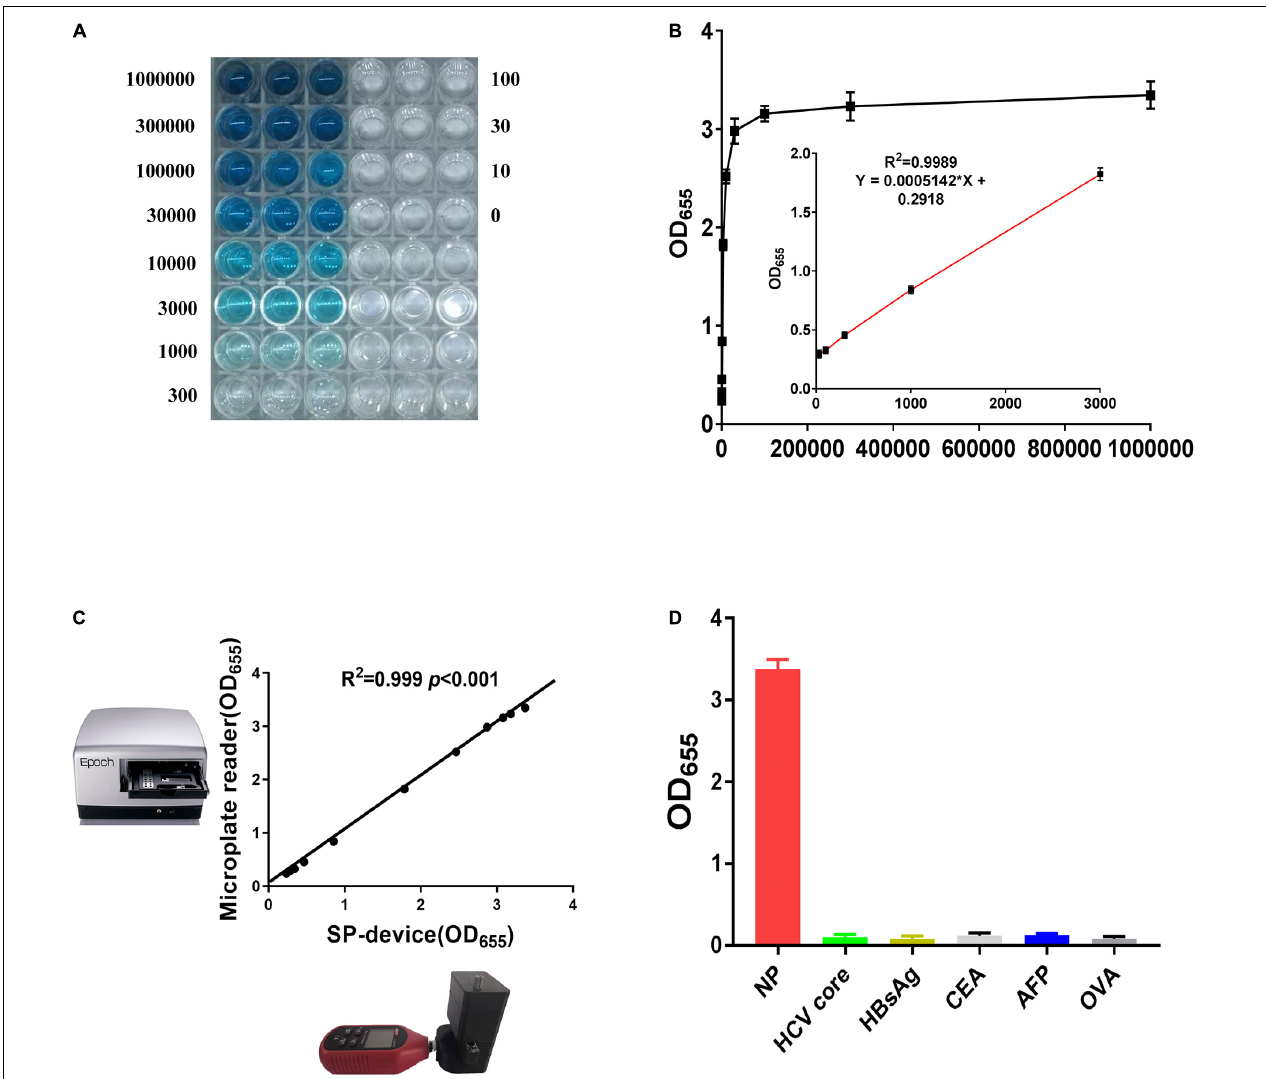
FIGURE 4 | The sensitivity and specificity of SP-NLISA. (A,B) The standard curve and linear range of SP-NLICA for NP detection. (C) The results tested by SP-device and commercial microplate reader exhibited an excellent correlation and no significant difference ( R 2 = 0.999, P < 0.001). (D) The specificity of SP-NLISA for NP detection. The added protein concentration was 1 µ